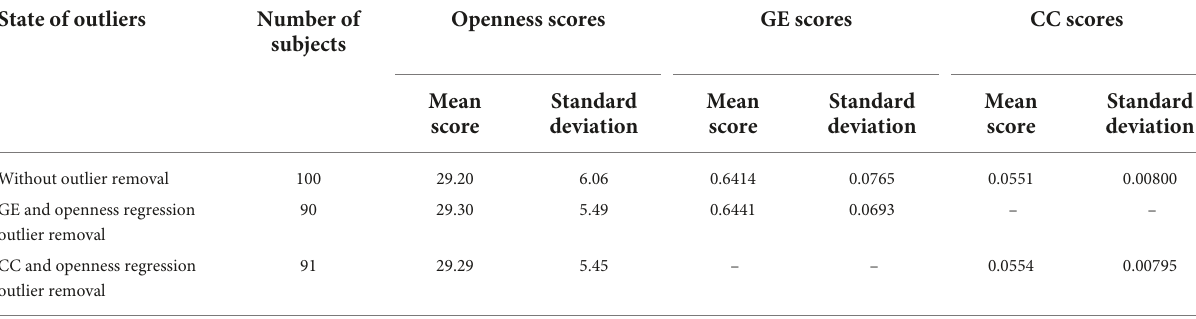
TABLE 1 The mean and standard deviation of openness to experience, GE and CC scores before and after outlier removal using the cook’s distance method.